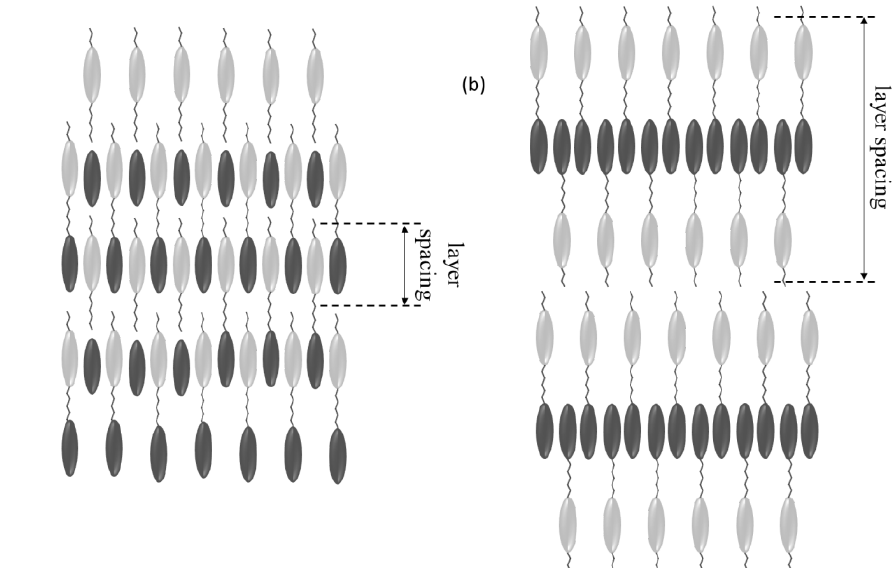
Figure 6. Sketches of ( a ) the intercalated and ( b ) the interdigitated smectic A phases shown by nonsymmetric liquid crystal dimers.